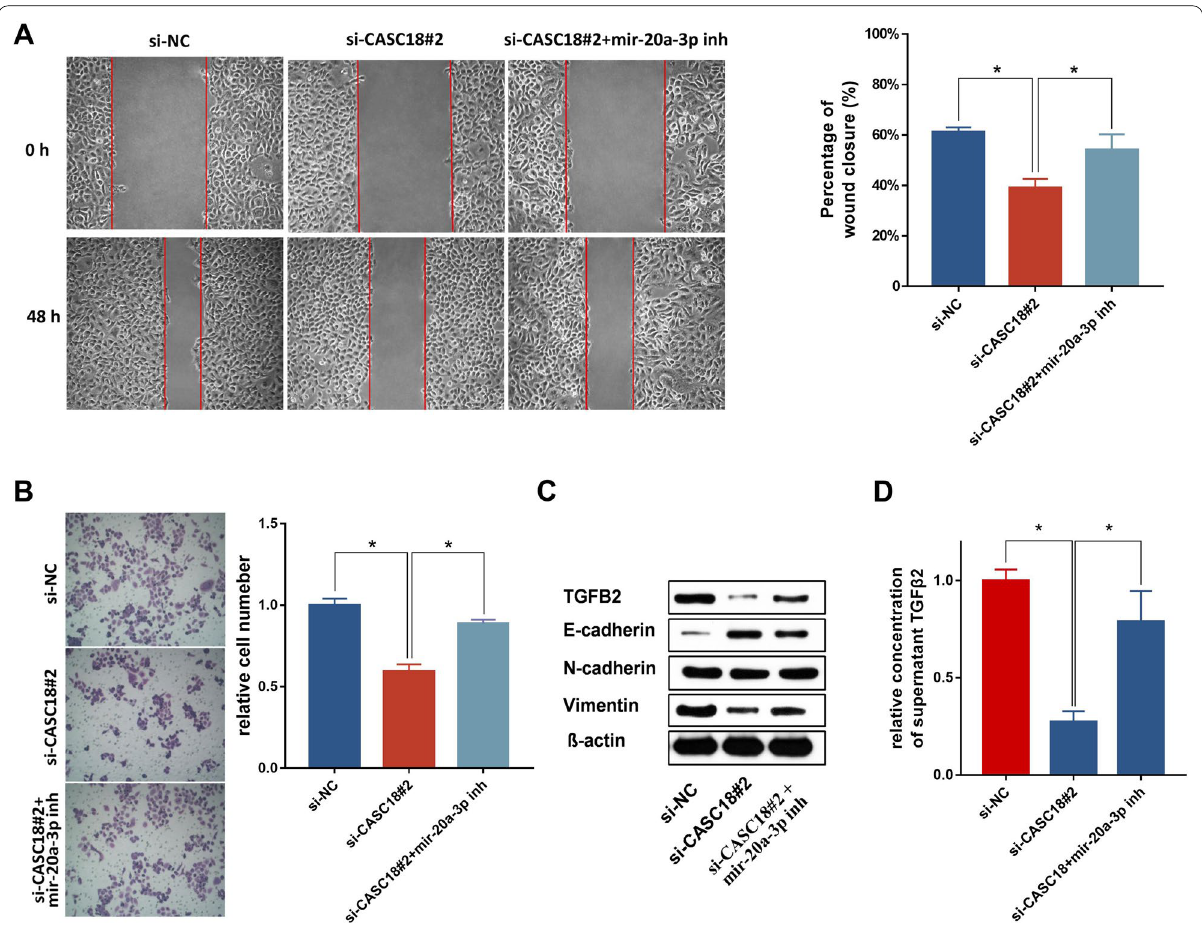
Fig. 7 Inhibitor against miR-20a-3p attenuates the repression effects of CASC18 knockdown on cell migration and invasion The effect of miR-20a-3p inhibitor on A cell migration and B invasion of CASC18-silencing CAL27 was evaluated by wound healing and transwell assays, respectively. The right histograms denote the percentage of wound closure and the relative number of invaded cells, respectively. The impact of miR-20a-3p inhibitor on C the expression of TGFB2 and EMT-related biomarkers and D secretion of TGFB2 in CASC18-silencing CAL27 by wester blot and ELISA, respectively. miR-20a-3p inh meant miR-20a-3p inhibitor. Data are presented as the mean